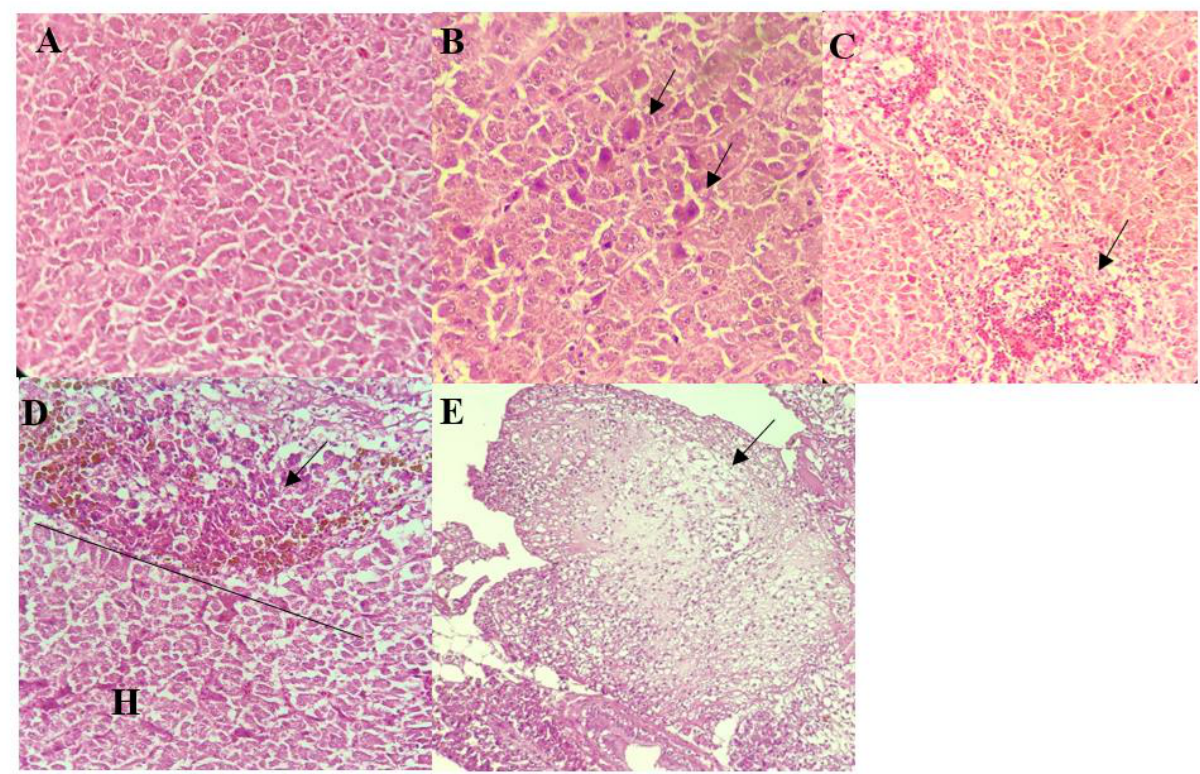
Figure 2. Histological findings of the liver of control and infected red hybrid tilapias by Aeromonas spp. ( A ) Liver of control fish showed normal liver architecture and hepatocytes, 400×. ( B ) Individual hepatocyte necrosis exhibiting intense cytoplasmic eosinophilia (arrows), 400×. ( C ) Extensive hydropic degeneration and necrosis of cells surrounding a central vein (arrow), 400×. ( D ) Infiltration of inflammatory cells. Note that some inflammatory cells are showing brownish cytoplasmic pigmentation suggestive of hemosiderosis (arrow) ((H): healthy cells), 400×. ( E ) Hepatic infarction showing complete loss of liver architecture (arrow), 400×.